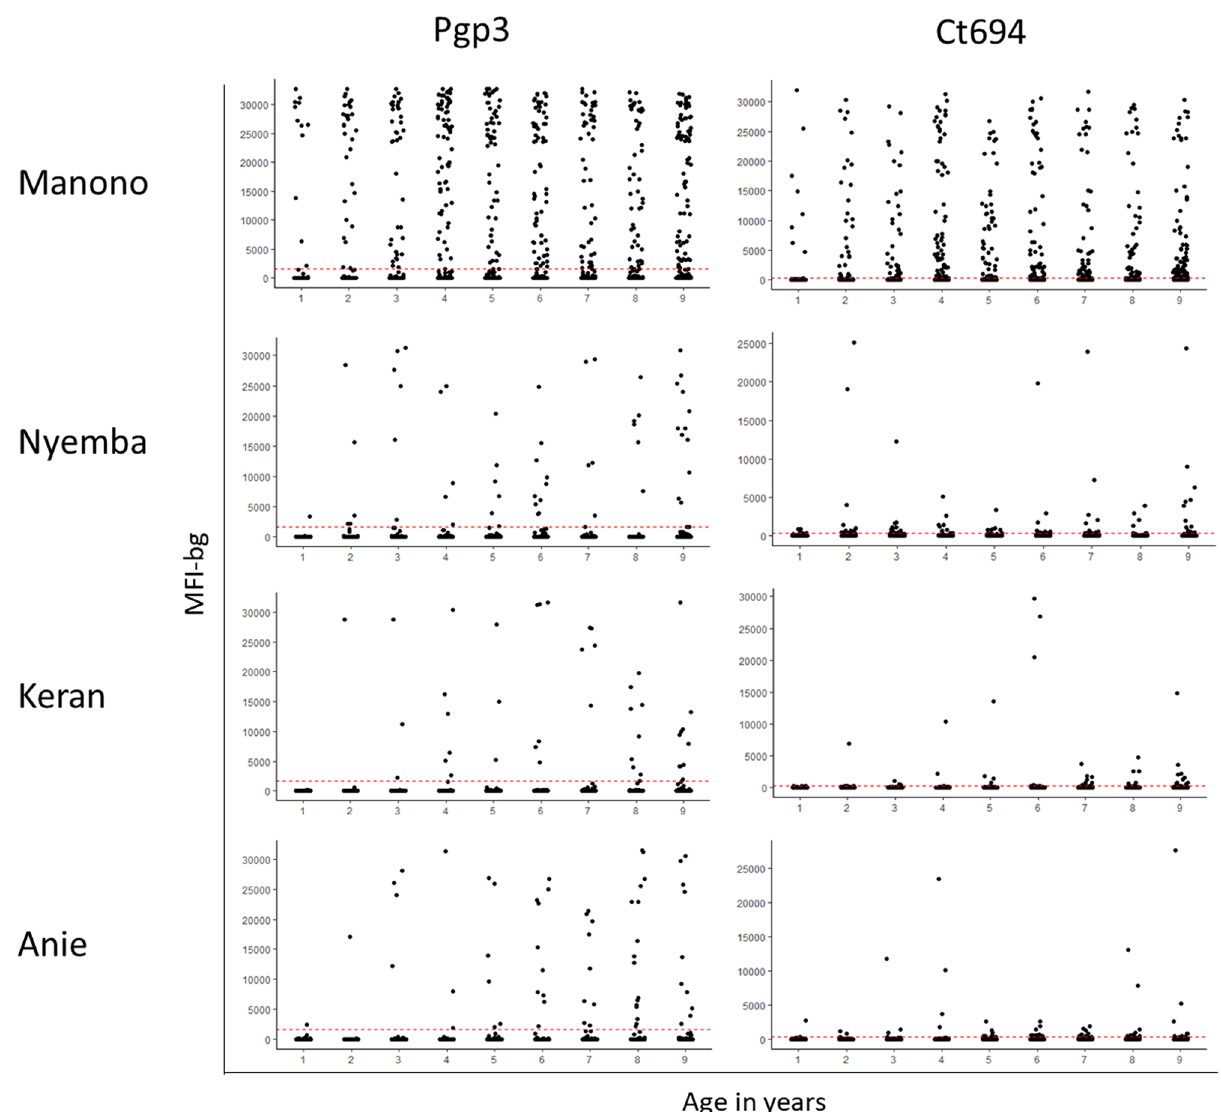
Figure 2. Intensity of antibody response (determined in the multiplex bead assay [MBA]) by age in each participating evaluation unit. Manono health zone, Democratic Republic of the Congo (DRC); Nyemba health zone, DRC; Keran district, Togo; Anie district, Togo. In each panel, the y-axis shows median fluorescence intensity with background subtracted (MFI-bg), and the x-axis shows age in years. Graphs were created using R version 3.6.3 (https:// www.r- proje ct.